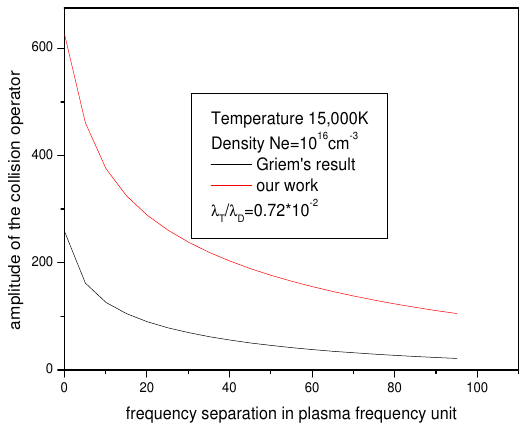
Figure 2. Amplitude of collision operator versus frequency separation in plasma frequency unit ¯ ω αα (cid:48) for Ne = 10 16 cm − 3 and 15,000 K. The amplitude is in π 2 A /768 unit, where A is defined in the text as Equation (26).